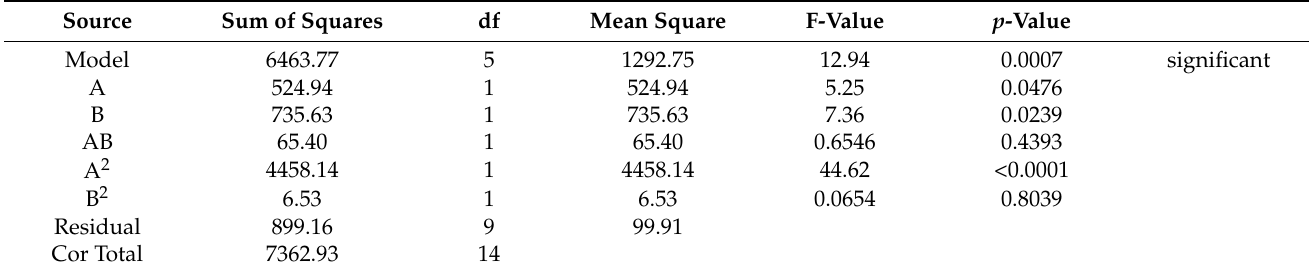
Table 2. ANOVA table for second output response